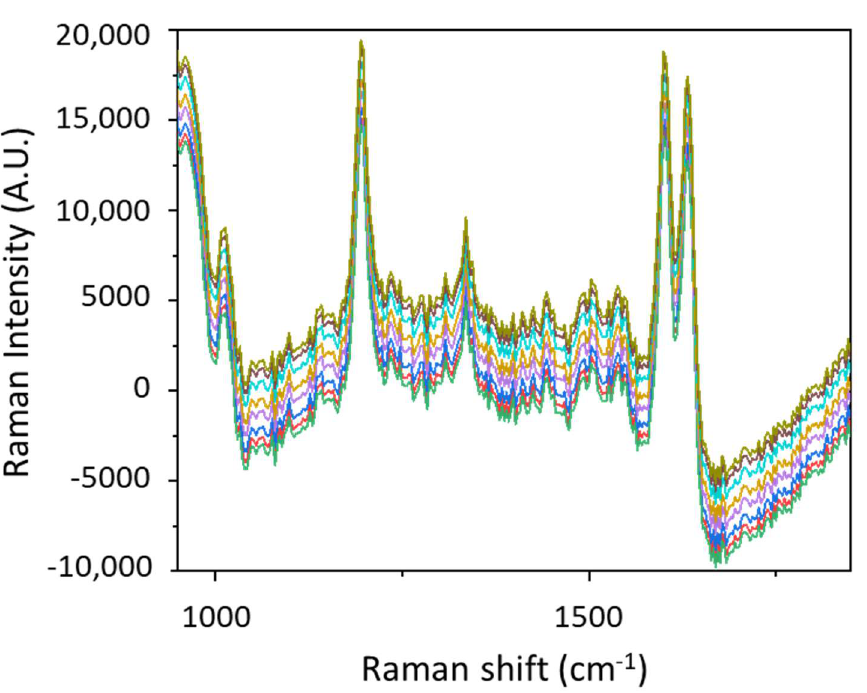
Figure 10. SERS spectra of 10 − 20 M of BPE probed at different zones on the substrate with a time interval of 1 month for the sample shown in Figure 8. Raman measurements were obtained with 10 − 2 M of BPE. Spectra were obtained at P = 10 mW over 5 s.